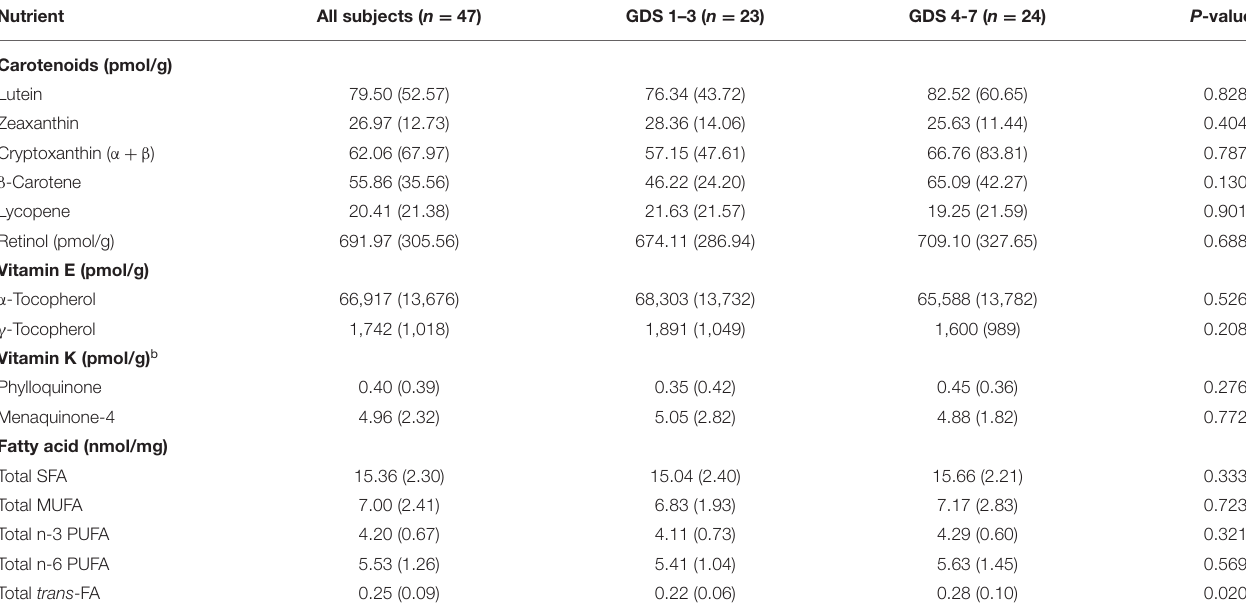
TABLE 2 | Mean (SD) of nutrient concentrations averaged from the frontal and temporal cortices (vitamin K only in the frontal cortex). Nutrient All subjects ( n = 47)